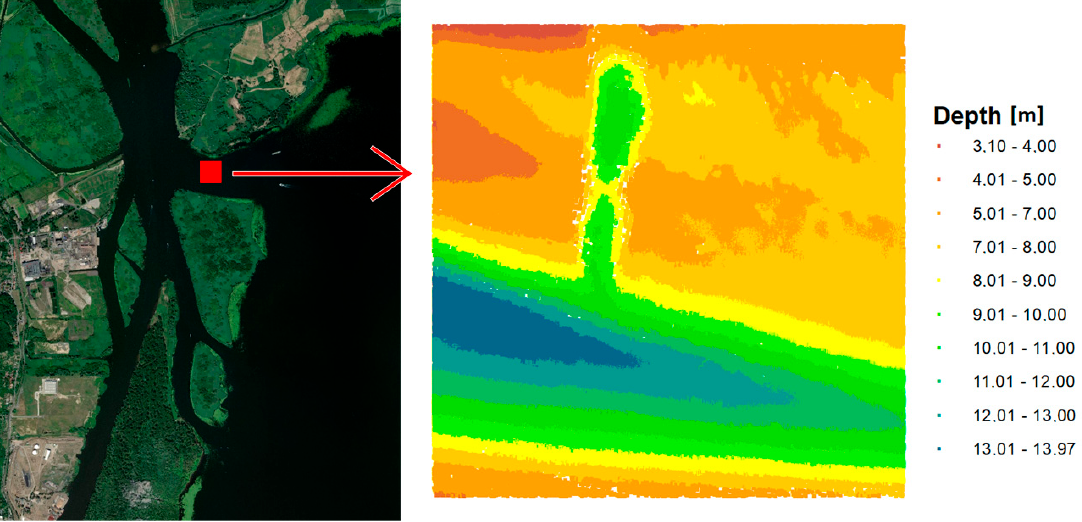
Figure 2. Test area no. 2—Inski canal.